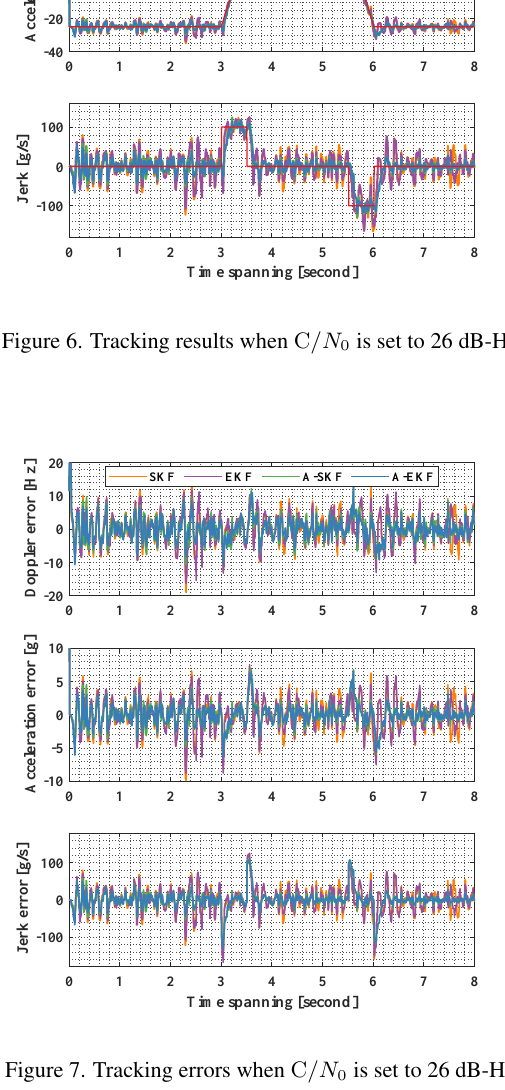
better than the EKF-based ones in the situation when the receiver signal power is